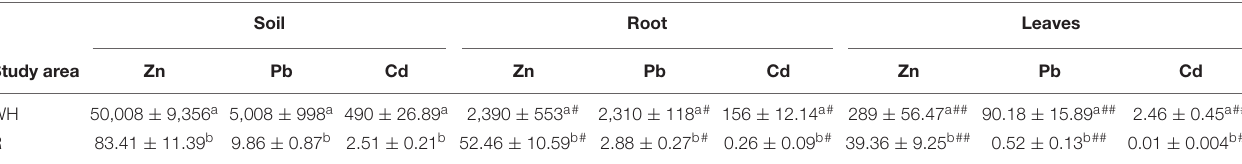
TABLE 4 | Zinc, lead, and cadmium concentrations (mg × kg − 1 dry soil) as well in roots and leaves of T. repens originating from the metal-polluted waste heap (WH) and the non-polluted reference (R) area. Soil Root Leaves